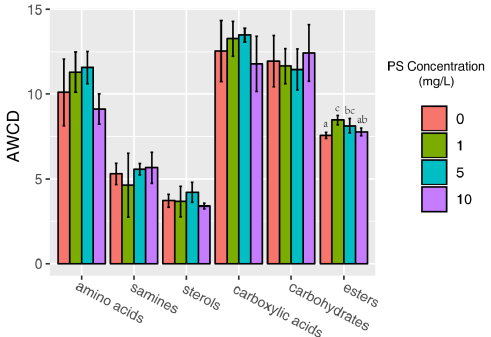
Figure 2. The AWCD by biochemical categories. Only the AWCD of esters reported significant differences ( p < 0.05) between the experimental and control groups. The letters of each column represent a significant difference at p < 0.05.